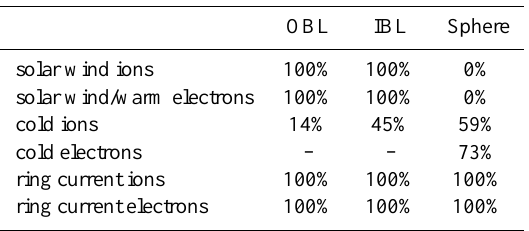
Table 1. Occurrence rate of plasma populations in the OBL, IBL, and magnetosphere proper, respectively OBL IBL Sphere solar wind ions 100% 100% 0% solar wind/warm electrons 100% 100% 0% cold ions 14% 45%